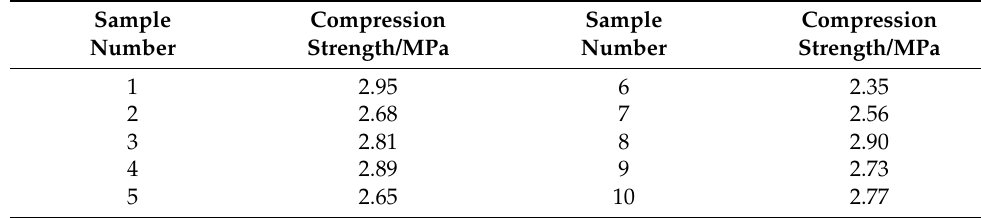
Table 2. Compression strength of lotus root.